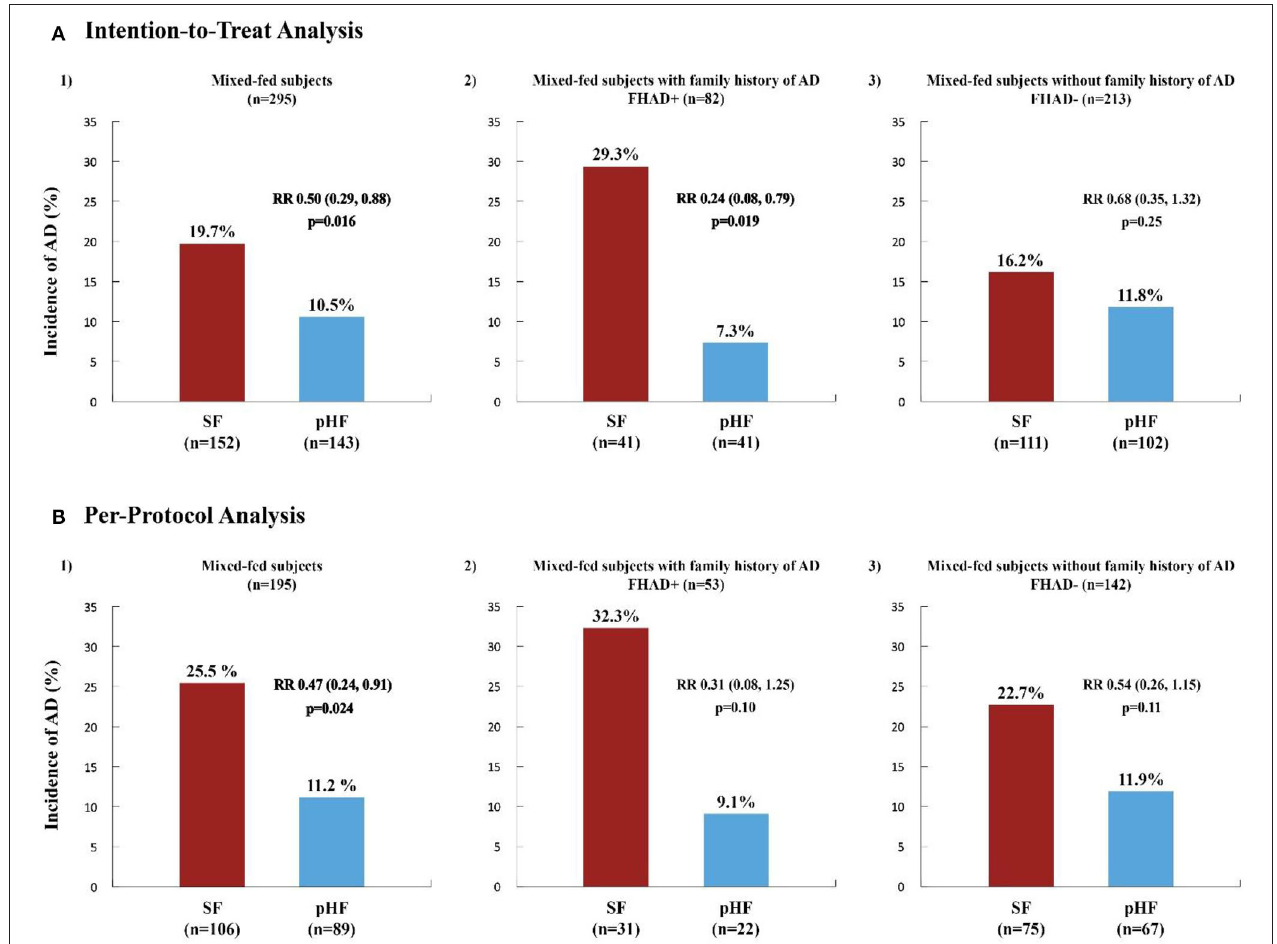
FIGURE 3 | Incidence and relative risk of atopic dermatitis within the first 6 months of life in high-risk mixed-fed infants. The incidence and relative risk (RR) of Atopic Dermatitis (AD) in high-risk infants within the first 6 months of life, in the whole mixed-fed population and in subjects mixed-fed with (FHAD + ) and without (FHAD-) family history of AD, generated from Poisson generalized estimating equation (GEE) regression analysis are presented in the Intention-to-Treat (ITT) (A) and Per-Protocol (PP) (B) Analysis. SF, standard formula (red columns); pHF, partially hydrolyzed formula (blue columns). A significant relative risk (RR, 95% CI) and risk reduction effect (%) of the pHF on the incidence of AD for the whole mixed-fed population was observed in both the ITT (A1) [RR 0.50 (0.29, 0.88), p = 0.016] and PP (B1) analysis [RR 0.47 (0.24, 0.91), p = 0.024], representing a risk reduction of 50% and 53% respectively. The reduction effect was most significant in those mixed-fed subjects with FHAD + [RR 0.24 (0.08, 0.79), p = 0.019] receiving the pHF, representing a 76% reduction on the incidence of AD (A2) . In the PP analysis (B2) only a trend was shown in this study group ( p = 0.10) whereas, no effect was observed for those infants without a family history of AD (A3, B3)